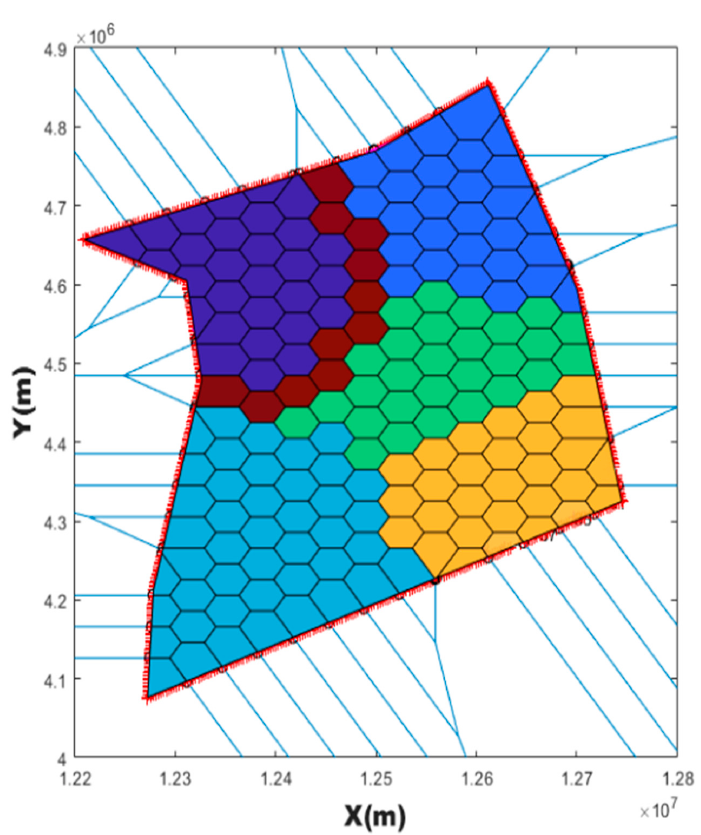
Figure 10. An example of the propagable neighborhood (crimson) of the sector (dark blue) with the smallest task load.